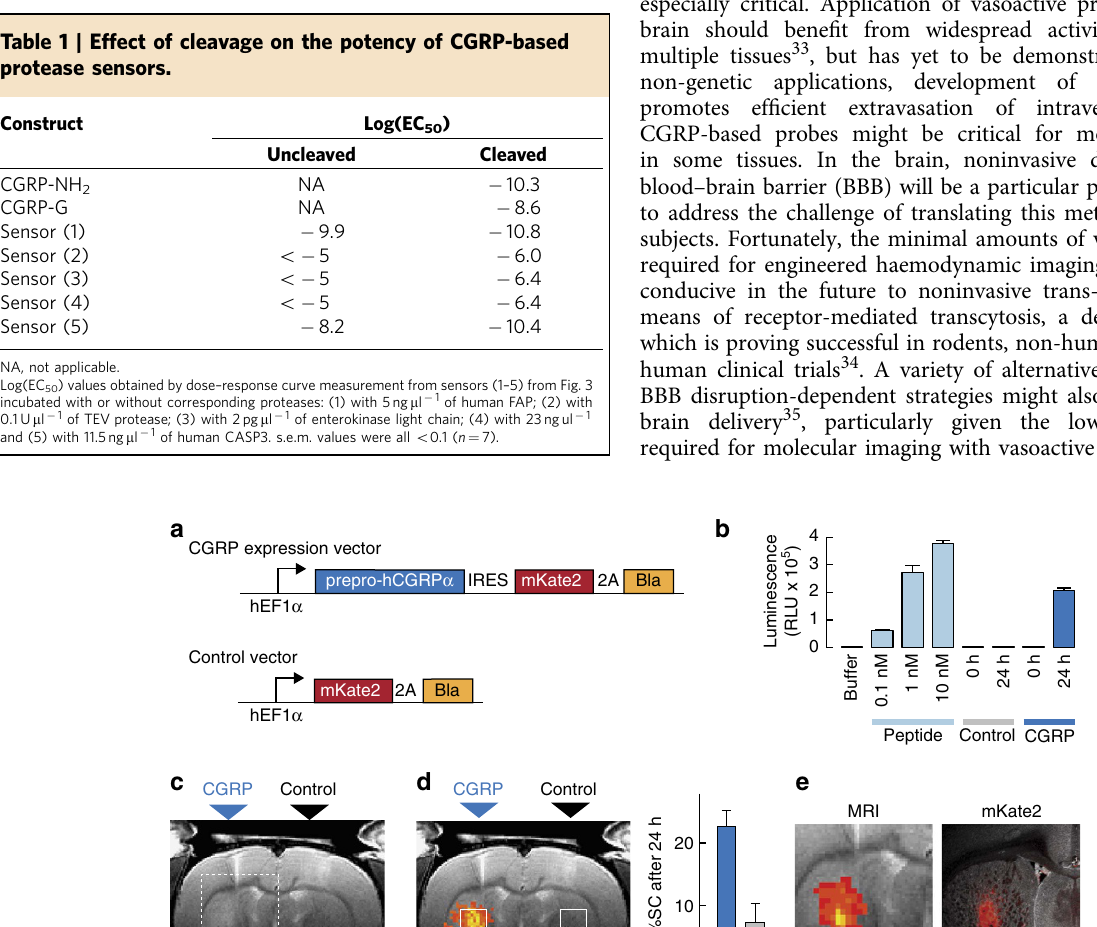
brains. A representative T 2 -weighted MRI scan obtained 24h after striatal injection of 3 (cid:3) 10 5 CGRP-producing or control cells (labels above) shows discernable signal enhancement consistent with probe-induced vasodilation in the CGRP injection region (dashed box) but not near the control injection site opposite. ( d ) Left: group-averaged map (left) displaying percent signal change (%SC, colour scale) observed between 0 and 24h after cell implantation, averaged over five animals. Right: mean %SC in the square regions of interest superimposed on the image. Error bars denote s.e.m. across five animals. ( e ) Correspondence of MRI signal change (left, colour scale as in d ) measured in vivo and mKate expression (right, red superimposed over a bright field image) visualized postmortem in a representative animal. The field of view corresponds to the rectangular box in c . Scale bar,